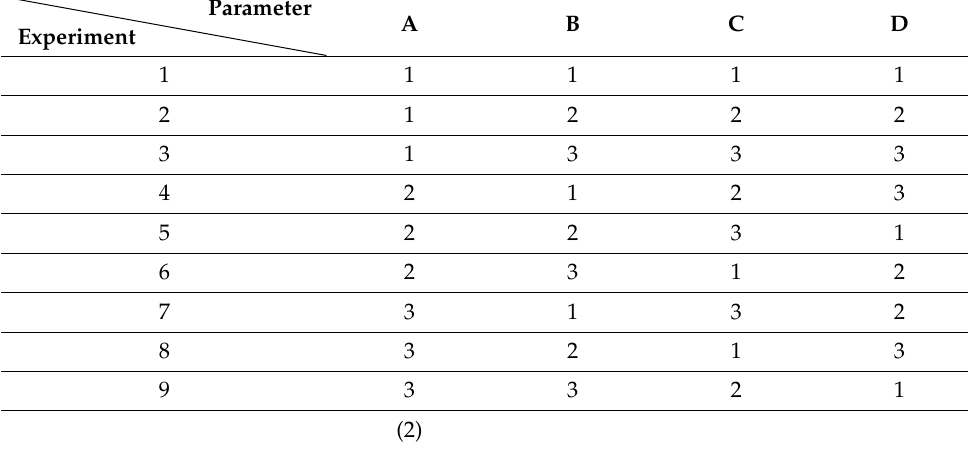
Table 3. The L 9 orthogonal array used for the main